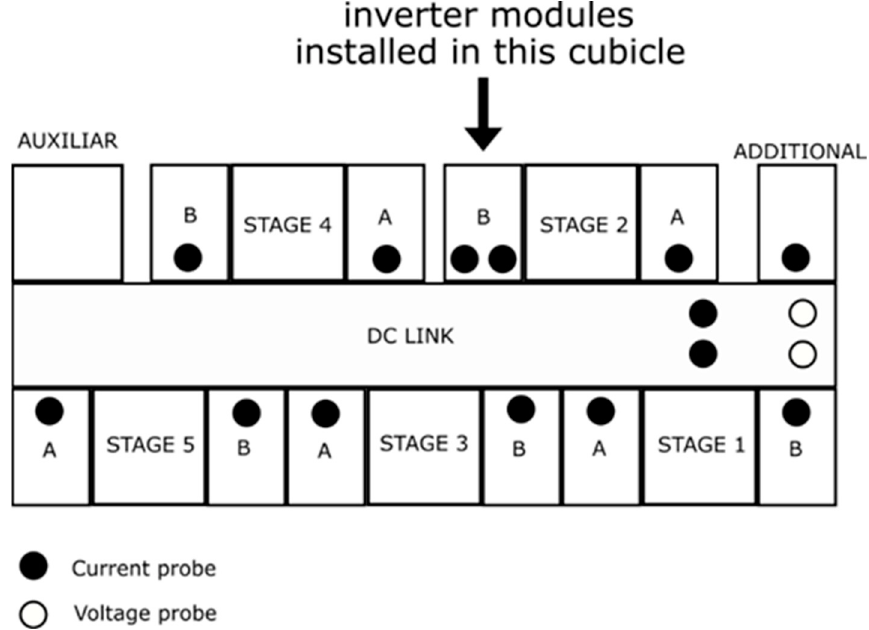
Figure 11. Layout of the inverter and dc-link cubicles, and installed probes during the